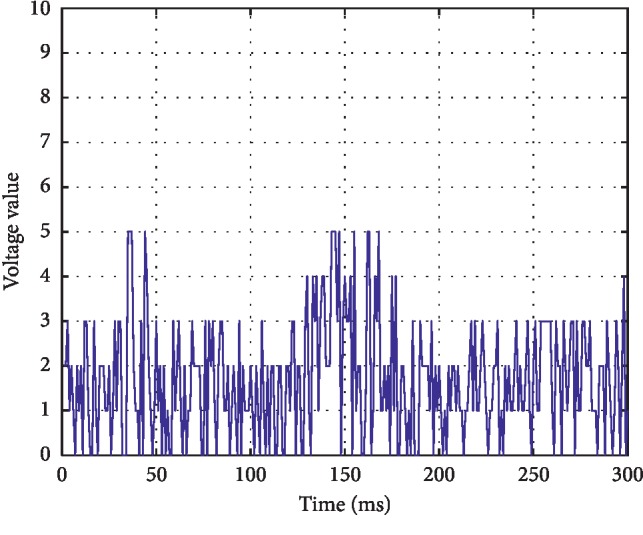
Continuous low-voltage mode below 5 μv.